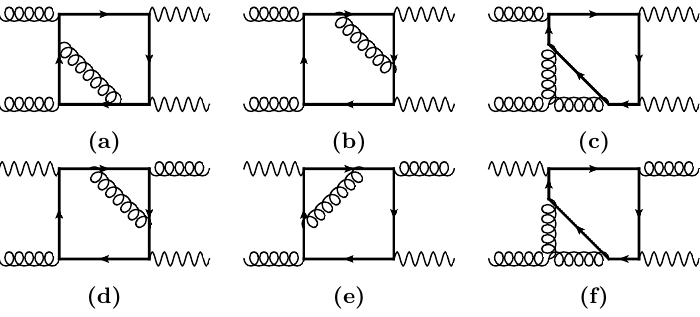
Figure 3. Representative Feynman diagrams in class A with reducible